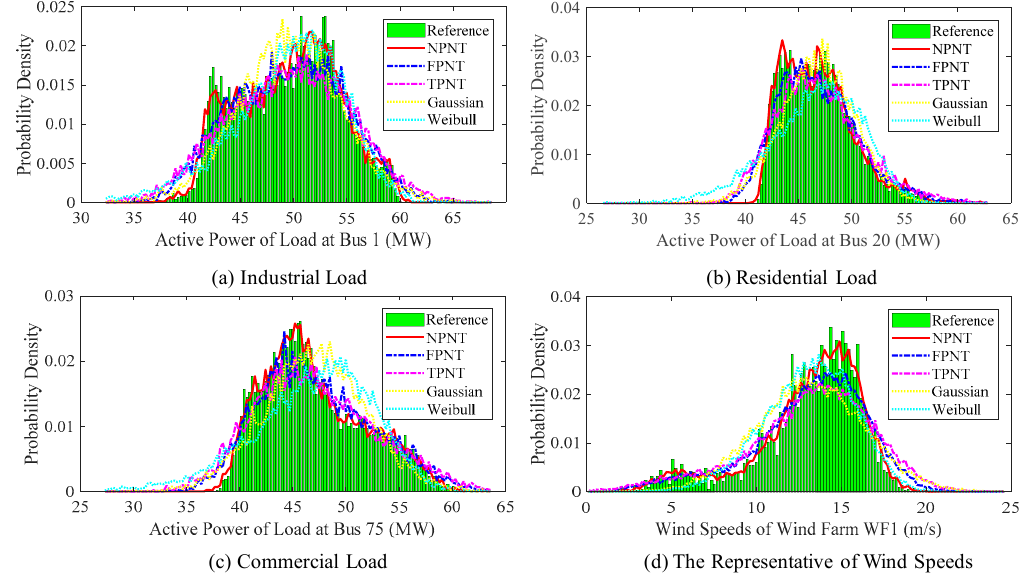
Figure 7. Frequency histograms obtained by historical records, NPNT, fifth-order polynomial normal transformation (FPNT), third-order polynomial normal transformation (TPNT), Gaussian, and Weibull distributions. Table 3. Frequency histogram similarity indexes (FHSIs) obtained by NPNT, FPNT, TPNT, Gaussian, and Weibull distributions.